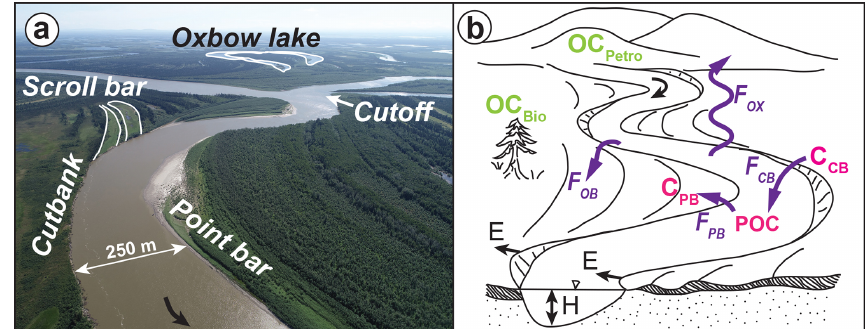
Figure 1. Overview of sediment erosion and deposition patterns in meandering river floodplains and important variables influencing the regional carbon cycle. (a) Drone photograph taken looking east across the Koyukuk River floodplain, Alaska (location marked with a white star in Fig. 2). The river flows south toward the bottom of the image (indicated by black arrow), eroding the cutbank on the outside of the river bend and depositing sediment on the point bar. Channel migration generates bands of higher and lower elevation sections of floodplain called scroll bars. As the river migrates, an individual bend becomes more sinuous, eventually cutting itself off and abandoning a section of channel, which becomes an oxbow lake. (b) Schematic of a meandering river floodplain, with channel geometry variables shown in black and particulate organic carbon reservoirs and fluxes into and out of the river control volume shown in purple. The river has bankfull depth H and migrates laterally at rate E , maintaining a constant channel width. Organic carbon is stored in the river cutbanks ( C CB ) and point bars ( C PB ) and is transported in the river as particulates (POC). These reservoirs are mixtures of radiocarbon-dead (Fm = 0) petrogenic organic carbon (OC Petro ) and biospheric organic carbon (OC Bio ) that has been stored in permafrost (low Fm) or been recently fixed by the biosphere (Fm ≥ 1). Fluxes of organic carbon into and out of the river control volume include cutbank erosion ( F CB ), point bar deposition ( F PB ), overbank deposition ( F OB ), and oxidation of POC and DOC ( F OX